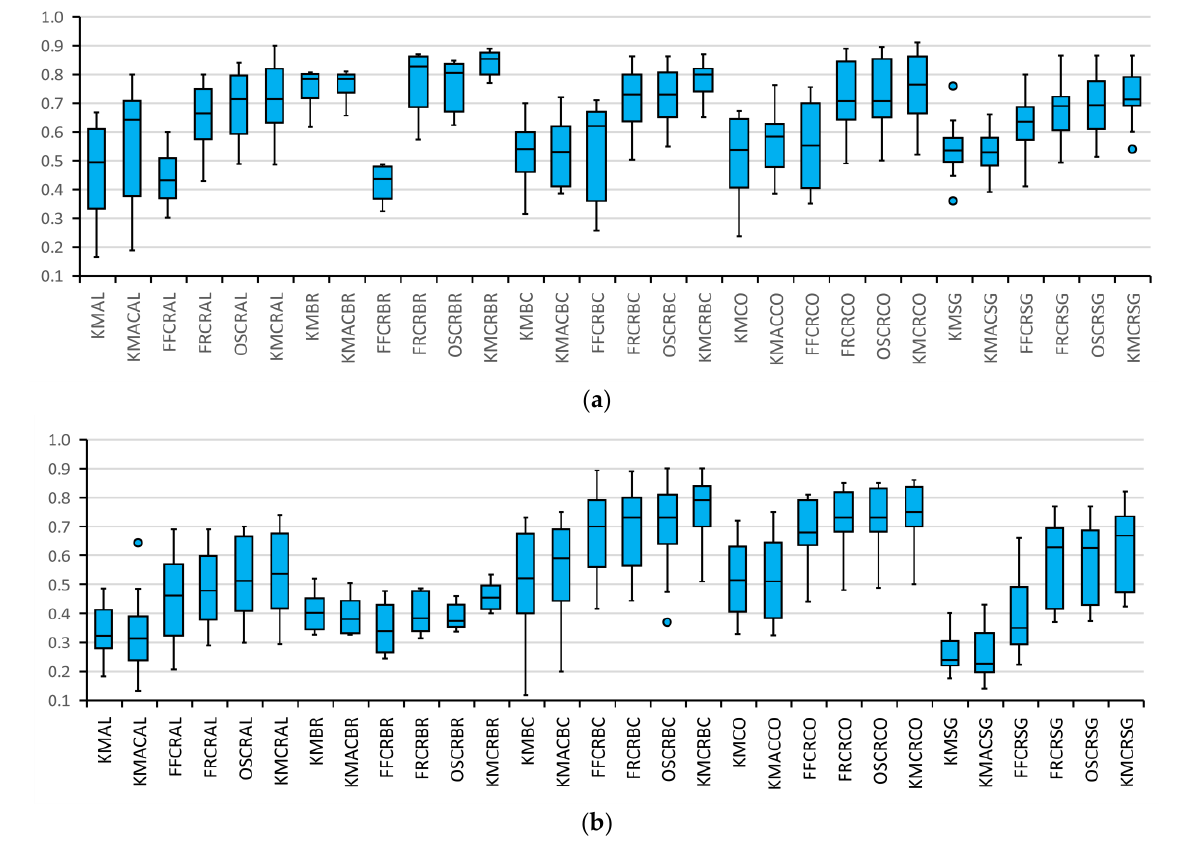
16 of 22 ( b ) Figure 33. Box-plot of the overall accuracy of all highly illuminated and low contrast benthic habitat images segmentation results based on the proposed algorithms: ( a ) F1-score; ( b ) IOU results. AL: algae, BR: brown Algae, BC: blue Corals, CO: corals, and SG: seagrass. Table 1. The average F1-Score and IOU results of the proposed algorithms on the tested highly illuminated and low contrast benthic habitat images. Benthic Habitat